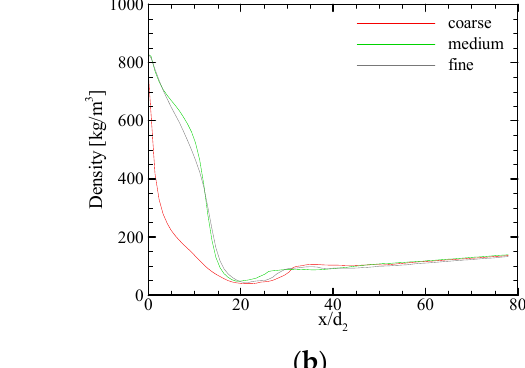
Figure 3. Grid overview with close-up view of injection region. d 1 : diameter of circular oxidizer pipe for straight section, d 2 : diameter of circular oxidizer pipe at exit, d 3 : inner diameter of annular fuel pipe, d 4 : outer diameter of annular fuel pipe.